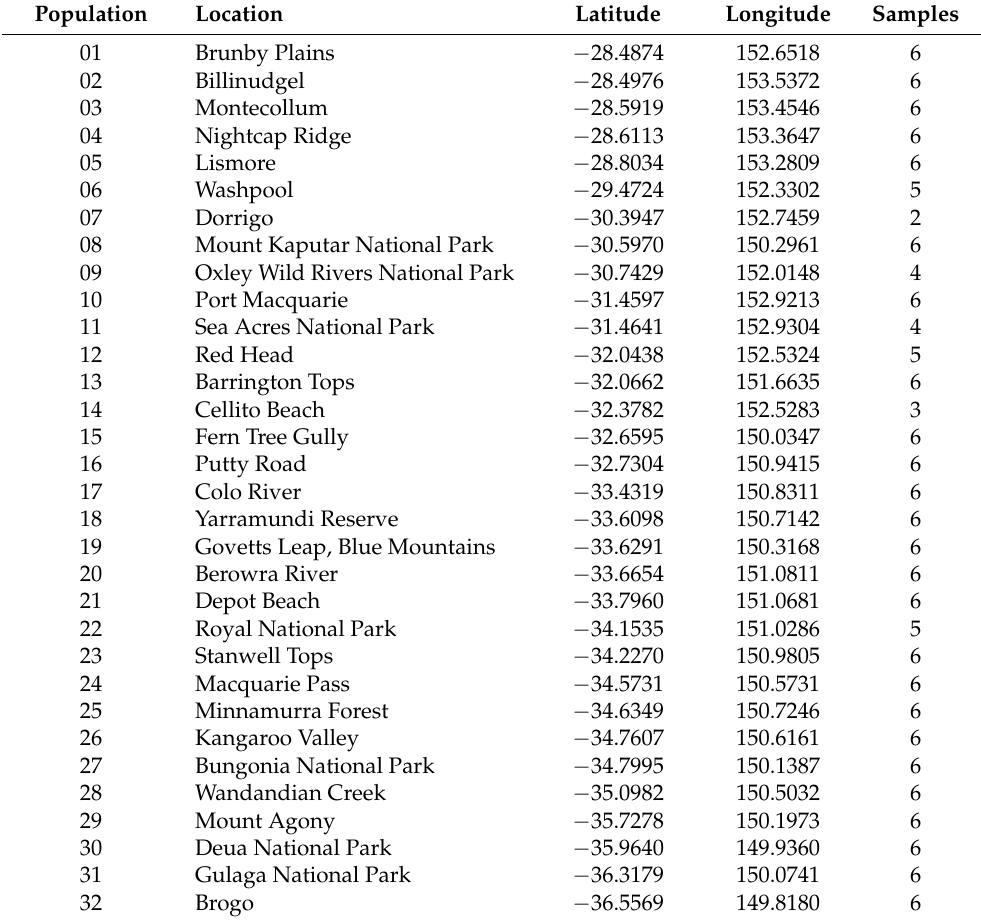
Table 1. Locations of Ficus coronata populations with a count of samples used in this study. Six samples were collected from Royal National Park, Red Head and Sea Acres though not all were successfully